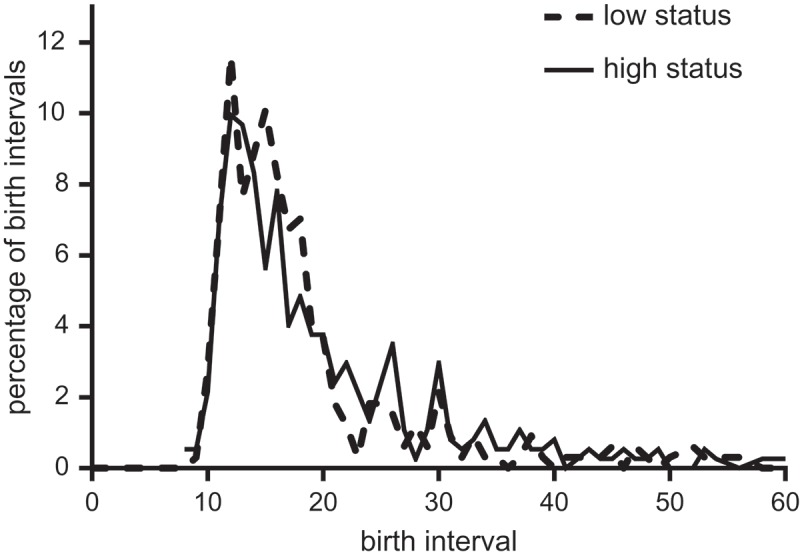
Distribution of birth intervals following the death of an infant in the first two months of life, by familial wealth, 1752–1794.
Notes: P value from Kolmogorov-Smirnov exact test for equality of distributions of birth intervals = 0.139.Source: St. Martin in the Fields family reconstitution.